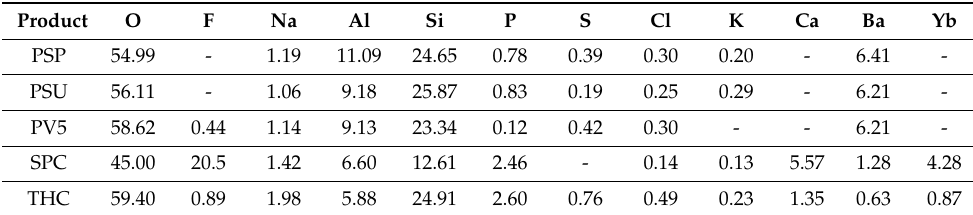
Table 5. The results of the elemental analysis by EDX (atomic %).